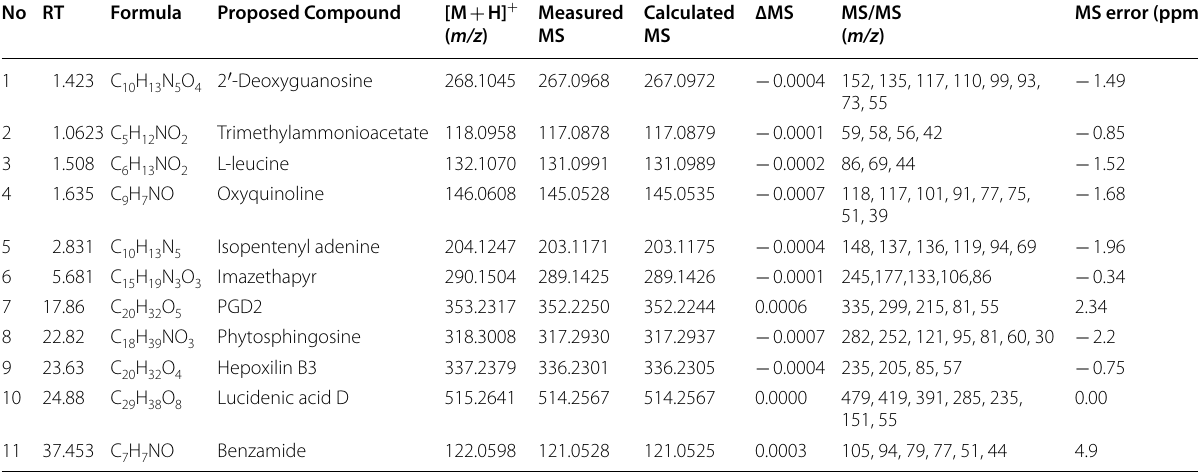
Table 3 Compounds preliminary identified from aqueous extracts of Cladosporium subuliforme by UPLC‑Q/TOF‑MS No